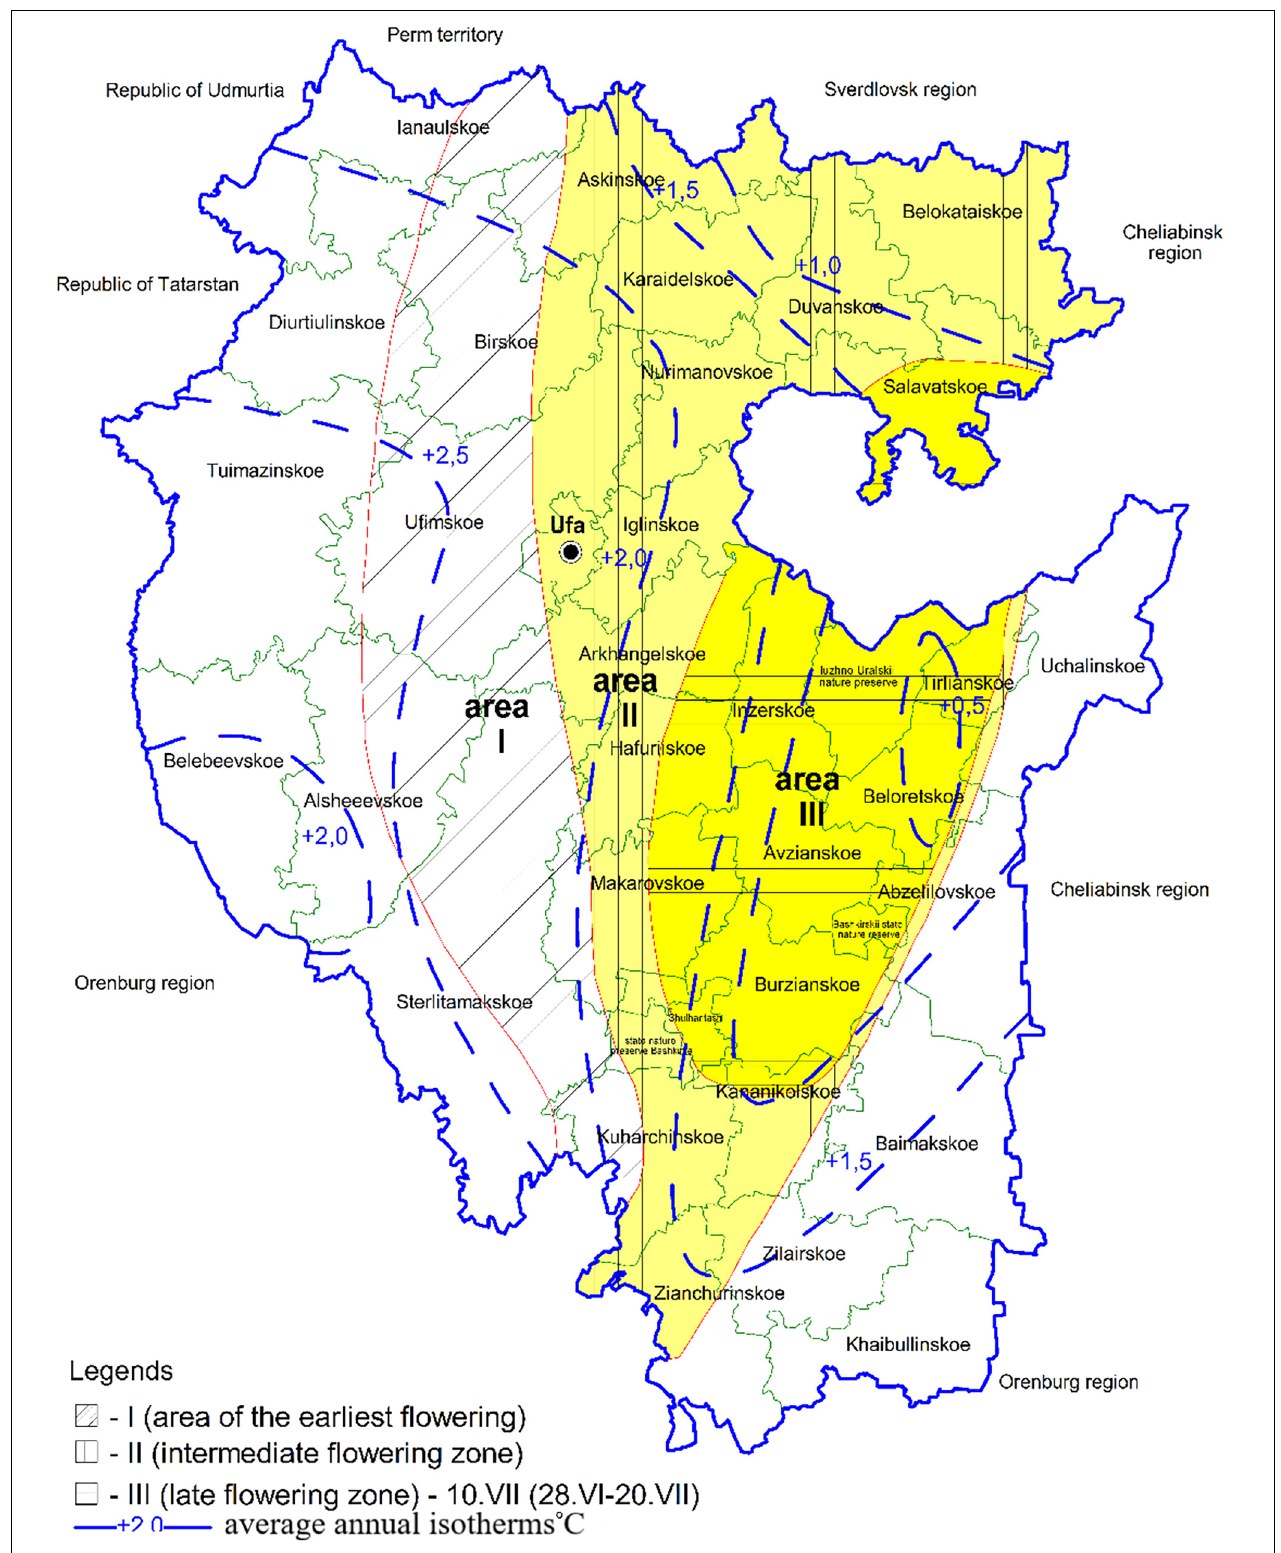
FIGURE 3 | Phenological zones according to the timing of linden flowering.